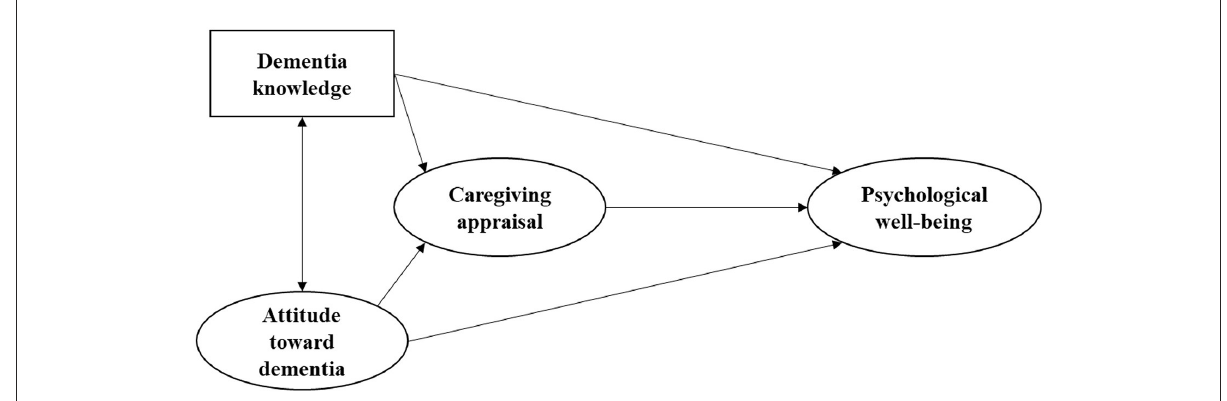
FIGURE1 The hypothesized model based on theory and